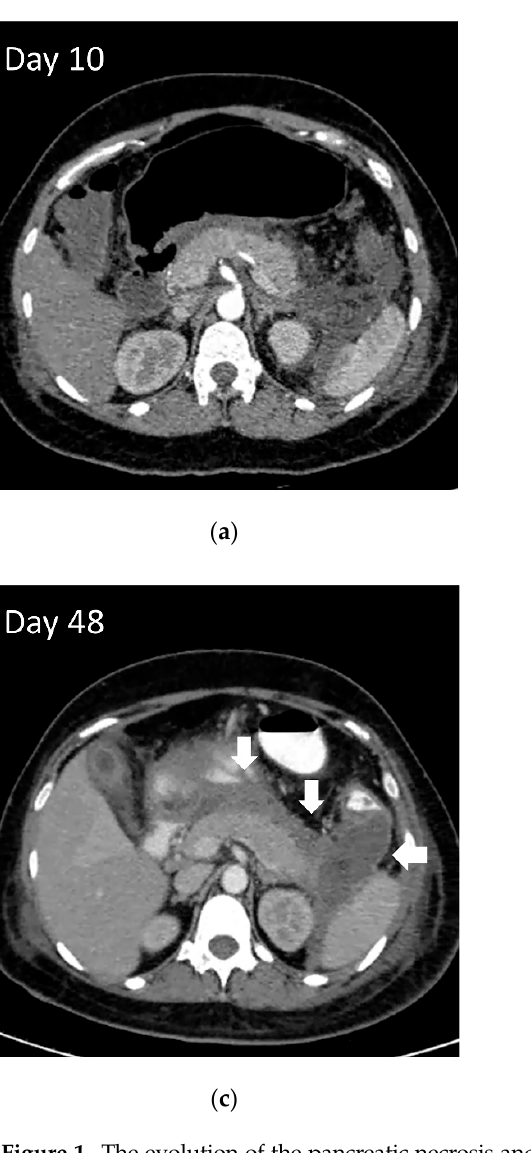
Figure 1. The evolution of the pancreatic necrosis and well-encapsulated walled-off necrosis. ( a ) The encapsulation was not completed 10 days after onset. ( b , c ) The peripancreatic fluid collection formed an encapsulation (arrow) within two weeks of the onset. ( d ) This patient developed infected walled-off necrosis with a cavity containing air bubbles (arrowhead) that needed drainage at day 68 after the onset of pancreatitis.